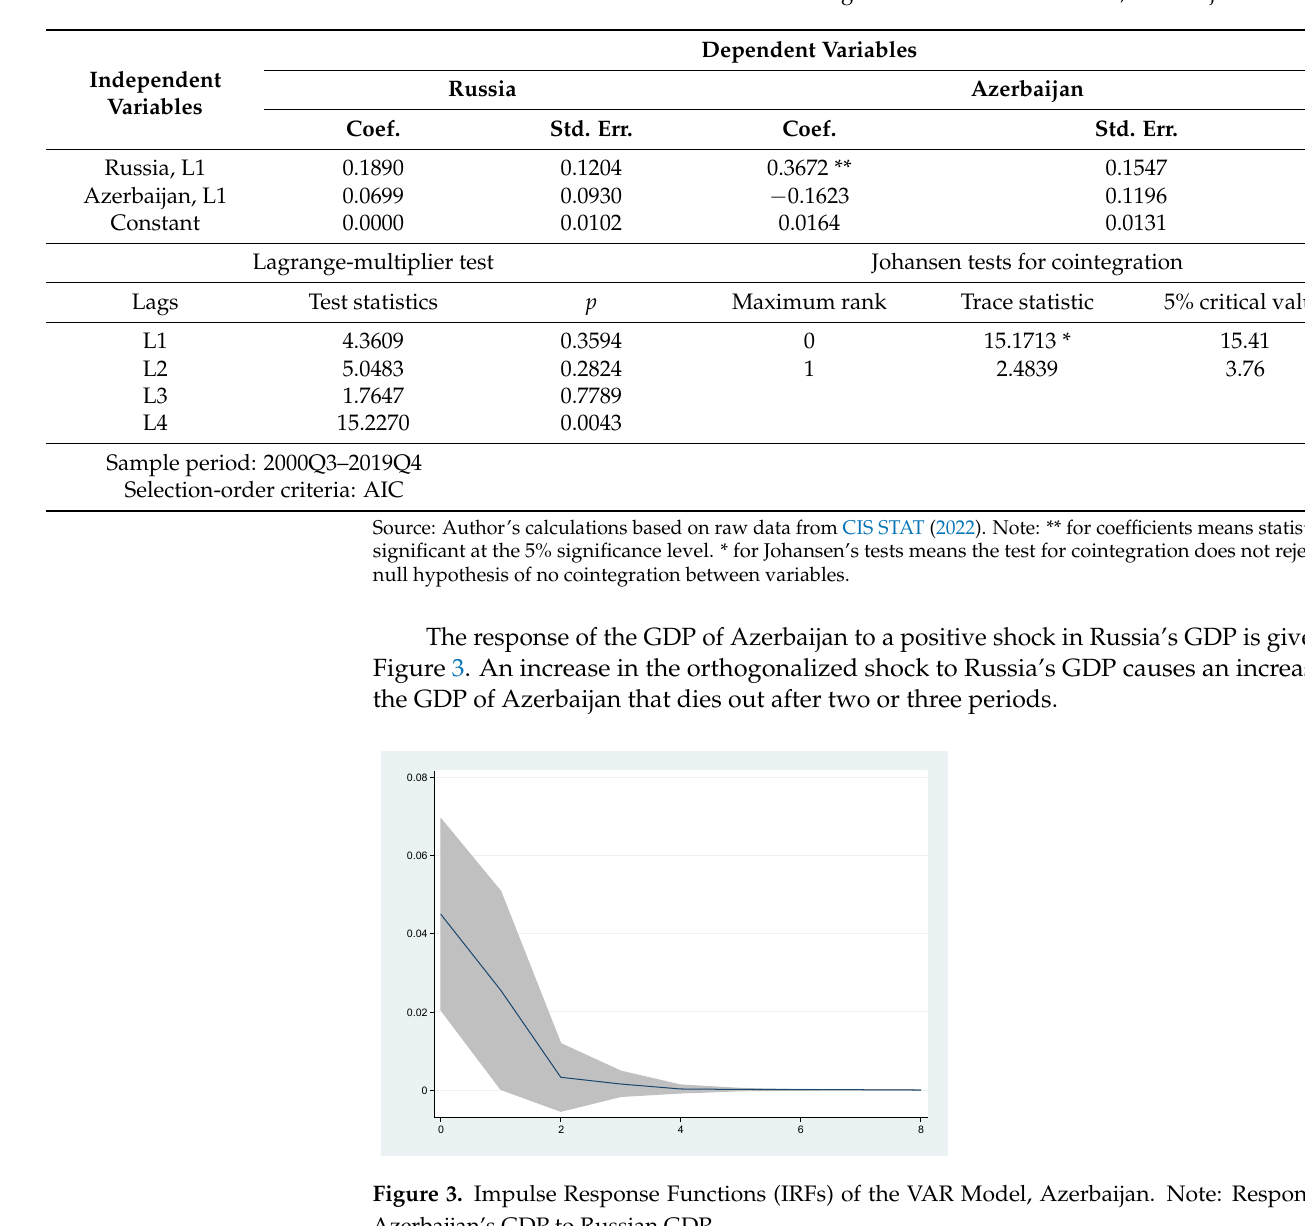
Table 10. VAR Model Estimation Results for Logarithmic Difference of GDP, Azerbaijan.